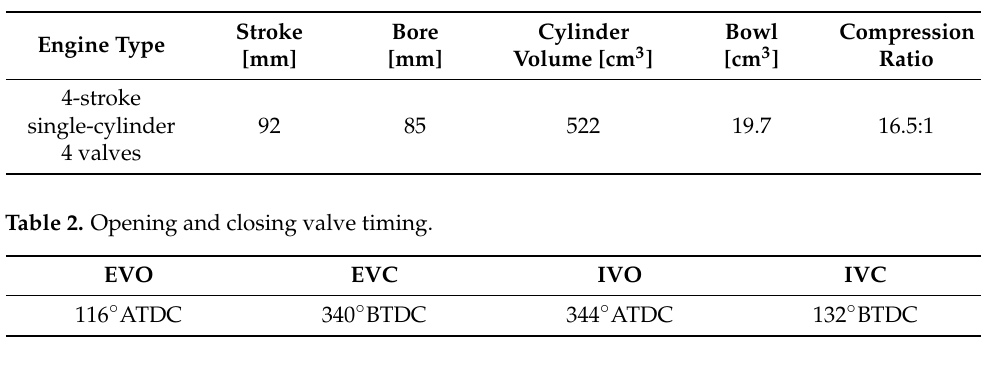
Table 3. Injection system